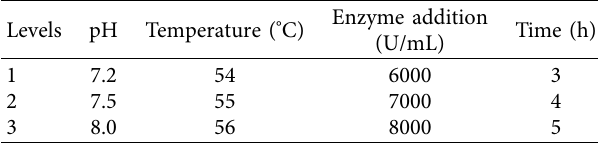
Table 1: Orthogonal factors table for polypeptide of C. militaris . Levels